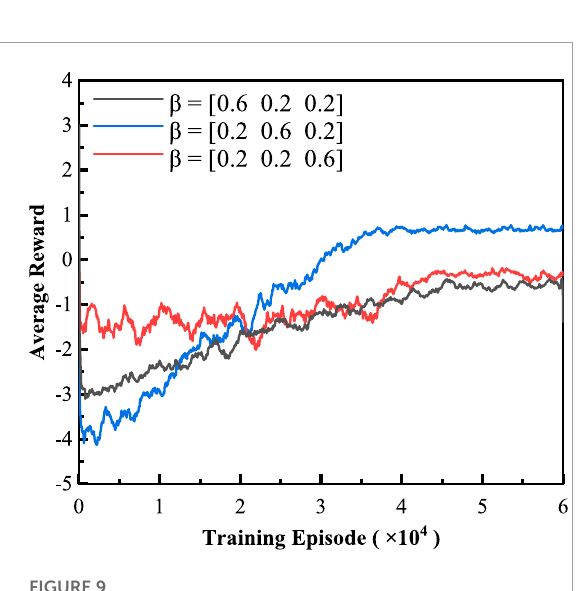
FIGURE 9 Training curves under different balance coefficient β based on